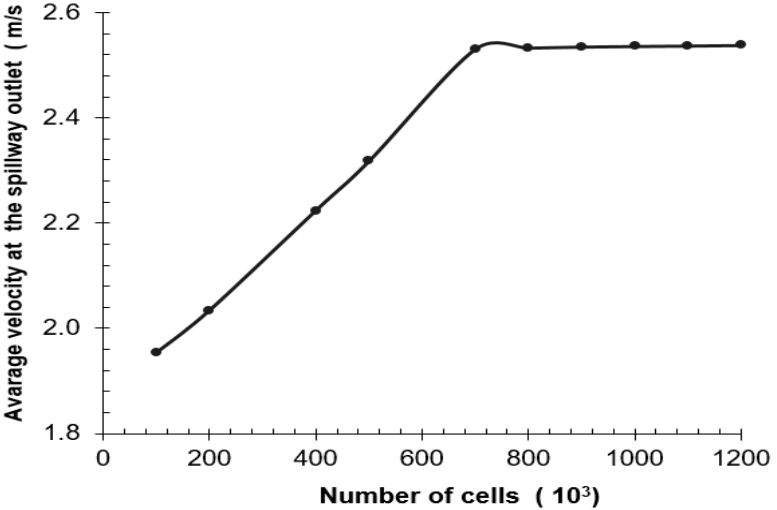
Figure 7. Grid independence test (number of cells vs. velocity at the spillway outlet).